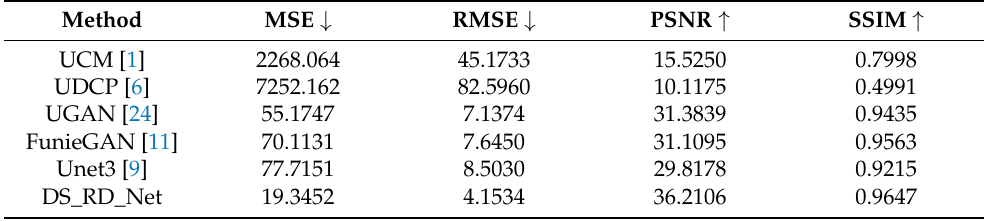
Table 3. Quantitative results evaluation on synthetic underwater datasets by full-reference